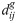
Representation of the ITN.Illustration of the tourism flow from Spain to Botswana, for which the geographical distance dijg is 7488 km and the chemical distance in the coarse-grained WAN dijc is 3, illustrating that tourists going from Spain to Botswana have to take at least two inter-country stopovers, travelling, for example, through Germany and Kenya, which is a much larger geographical distance than what separates the two countries. Note that the distance is measured between the centroids of each country. This figure was created by using the open-source software Gephi, which is distributed under CDDL 1.0 and GNU General Public License v3 [35].